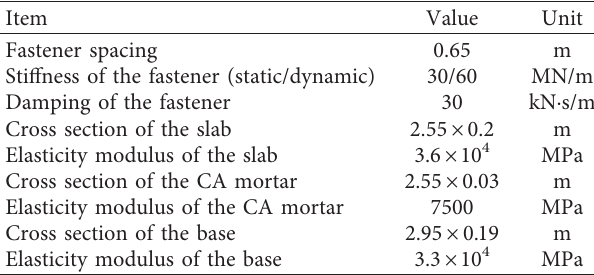
Table 1: Parameters of